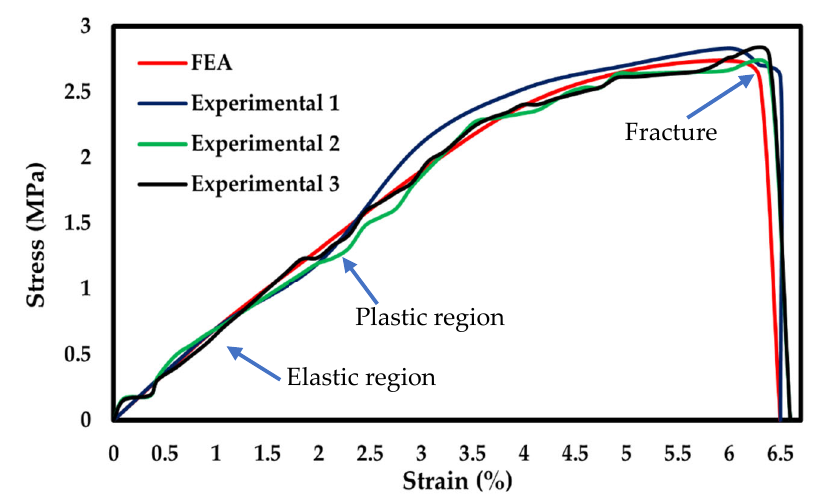
Figure 5. Stress-strain curve comparison of FEA with experimental. Figure 5. Stress ‐ strain curve comparison of FEA with experimental. Figure 5. Stress ‐ strain curve comparison of FEA with experimental.